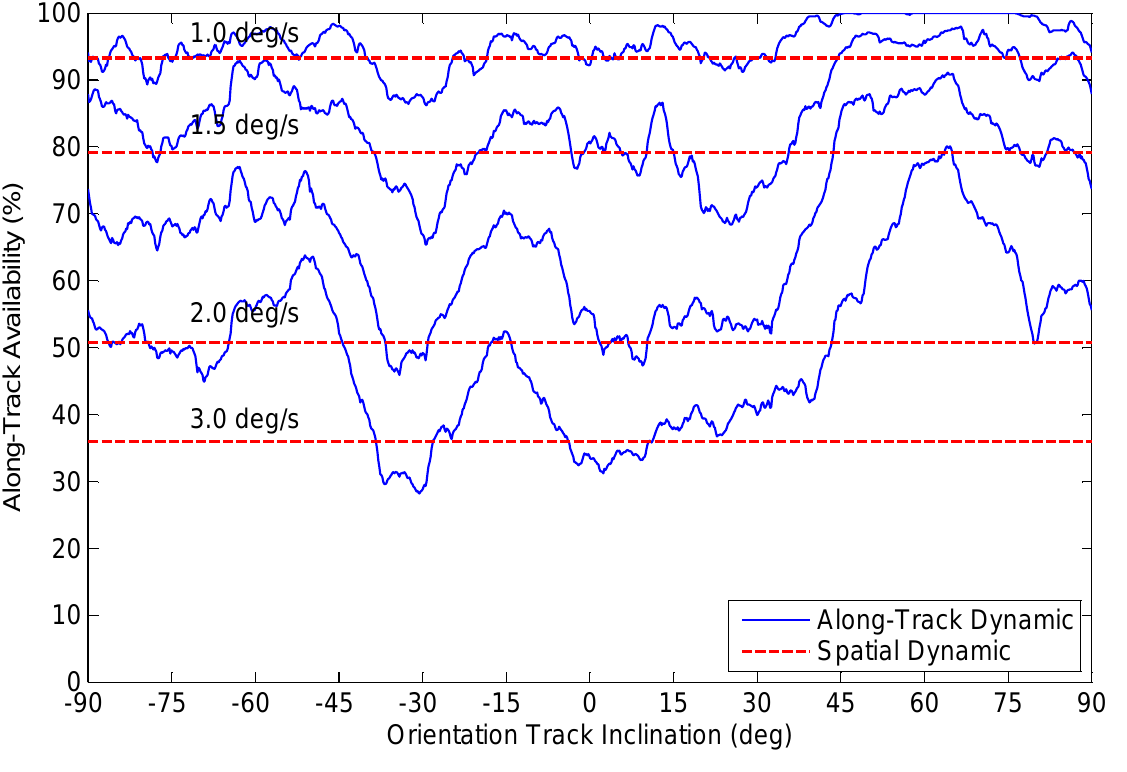
Figure 16. Examples of ST-16 along-track dynamic availability, N